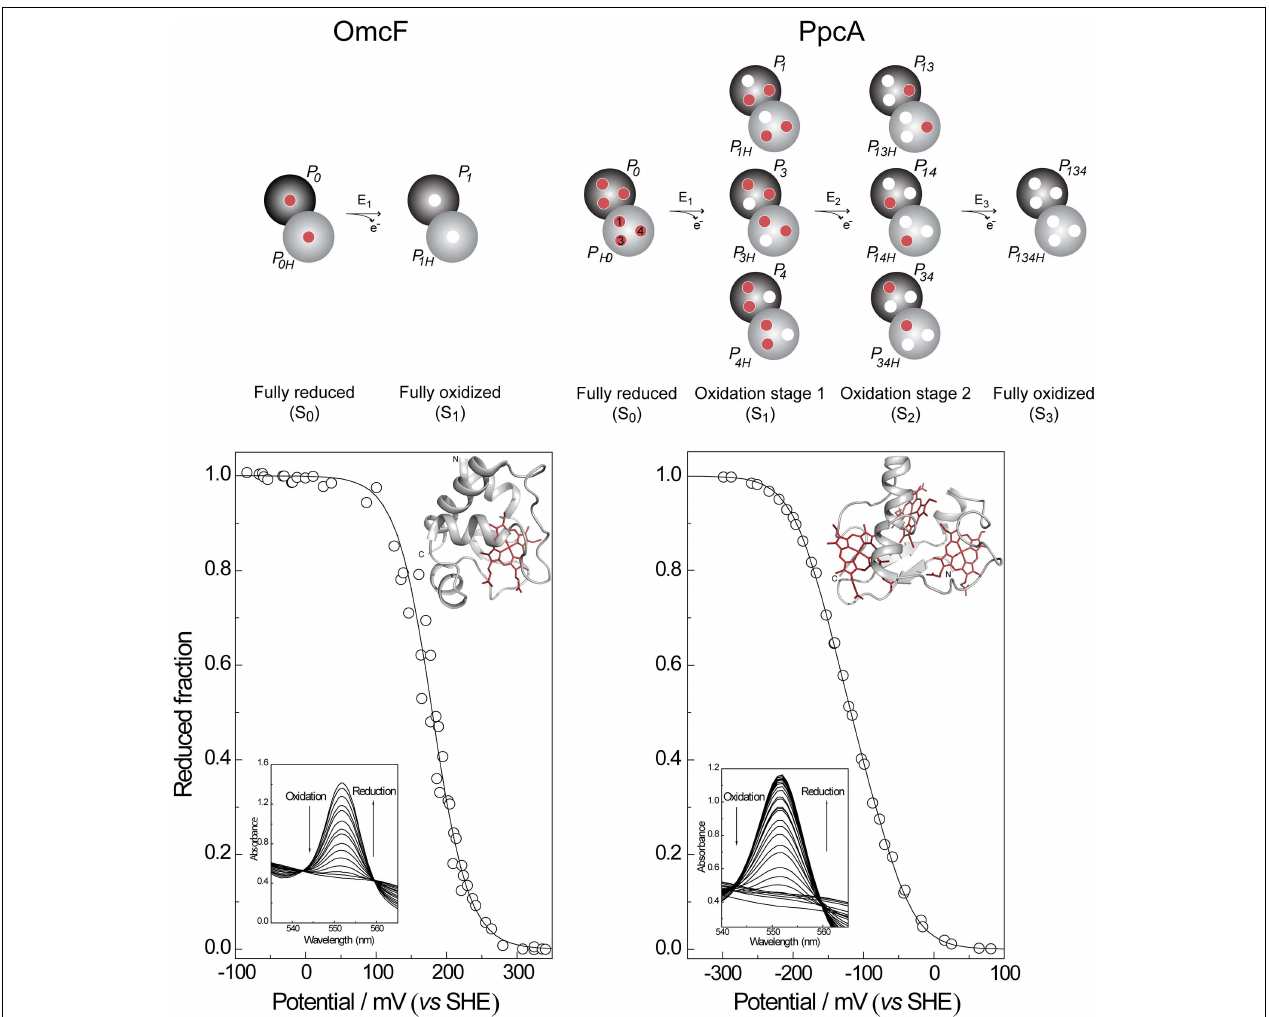
FIGURE 3 | Electronic distribution scheme for monoheme (OmcF) and triheme (PpcA) cytochromes showing the possible microstates in each situation. The inner circles represent heme groups, which can either be reduced (red circles) or oxidized (white circles). The microstates are grouped according to the number of oxidized hemes in each oxidation stage, connected by consecutive one-electron redox steps. P 0H and P 0 represent the reduced protonated and deprotonated microstates, respectively. P ijkH and P ijk , indicate, respectively, the protonated and deprotonated